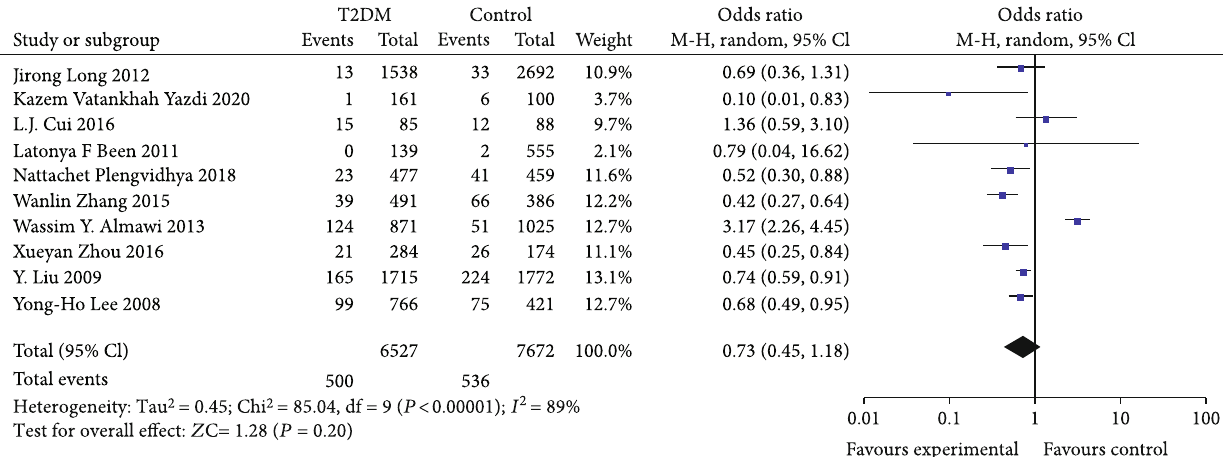
Figure 4: Forest plot of meta-analysis of the association between KCNQ12237892 locus and T2DM under the recessive model.